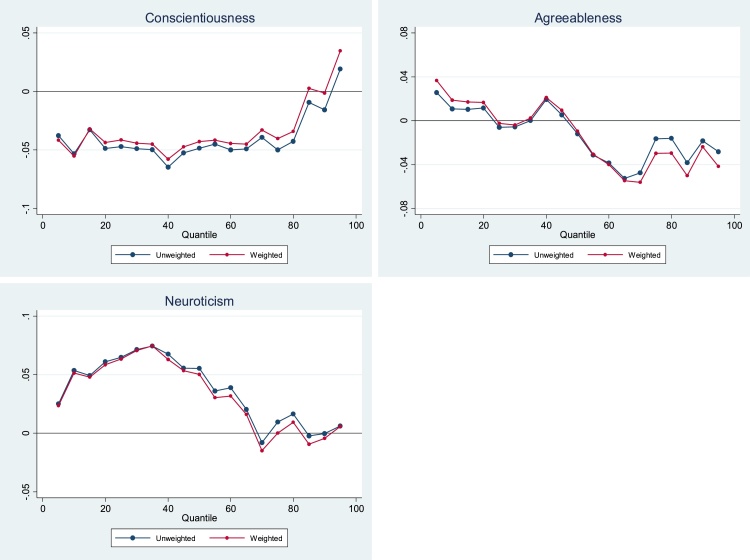
Weighted non-cognitive skills – triglyceride-HDL ratio relationship.